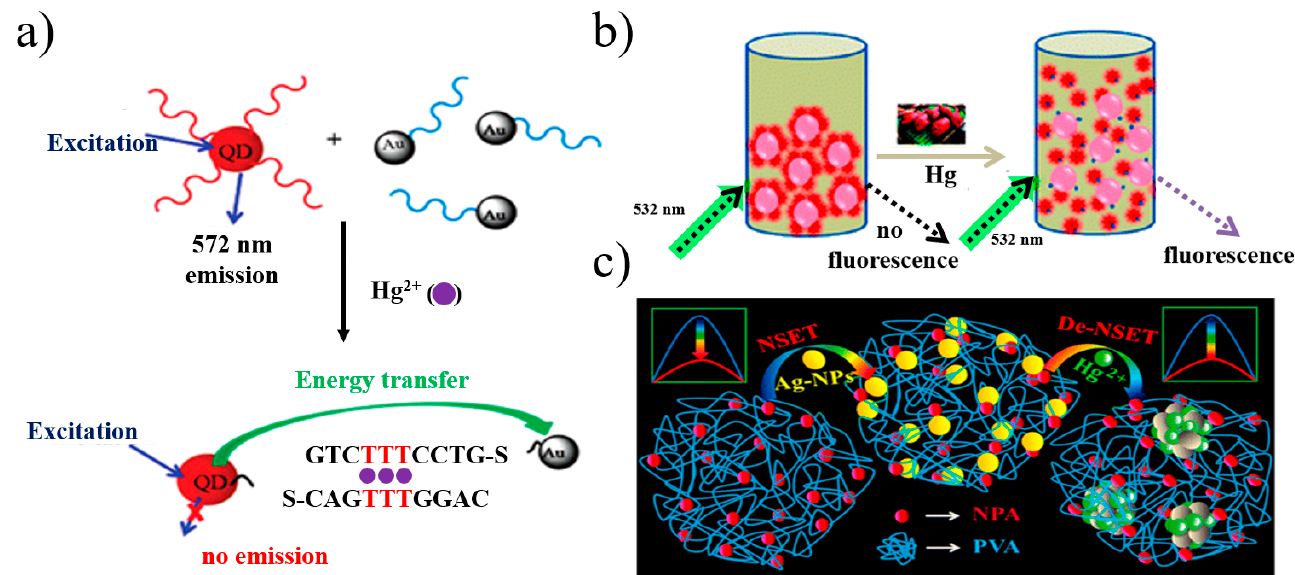
Figure 23. ( a ) Schematic diagram of the fluorescent sensor for Hg 2+ detection [95]. ( b ) Schematic diagram of Hg 2+ ion detection through NSET between rhodamine B and gold NPs [96]. ( c ) Schematic diagram of NSET modified by AuNP-doped PVA [97].